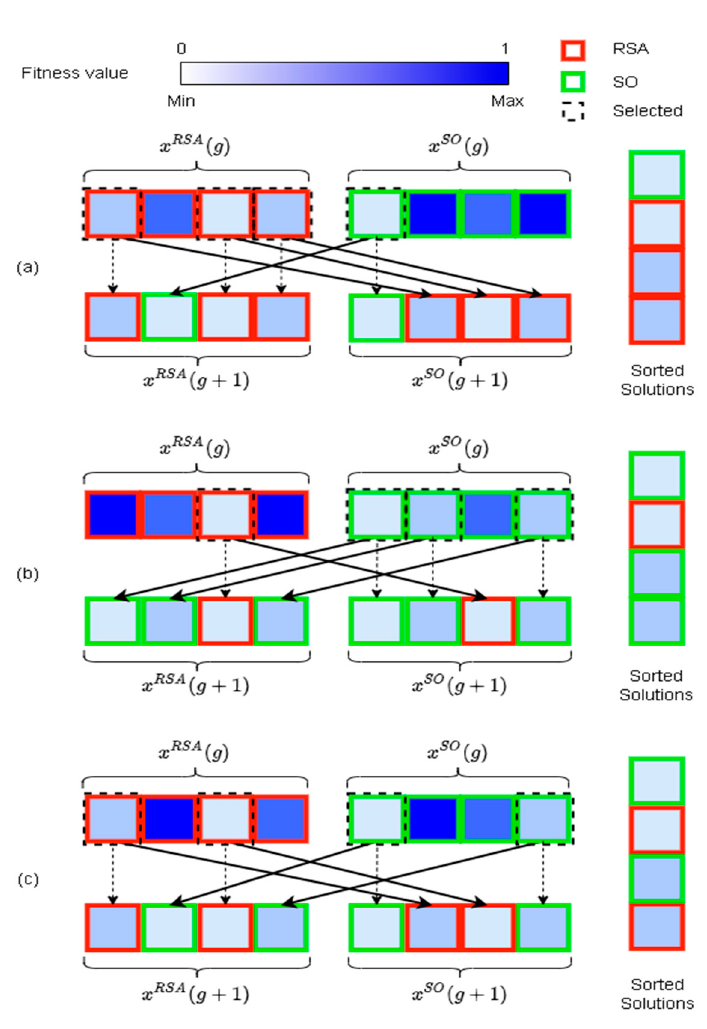
Figure 2. Example of optimizing the low ‐ fitness candidate solutions in the proposed RSA ‐ SO algo ‐ rithm for dominance of ( a ) RSA, ( b ) SO, and ( c ) codominance of both, as shown in Equation (19). Algorithm 1: Pseudo ‐ code of the interdicted RSA ‐ SO approach.